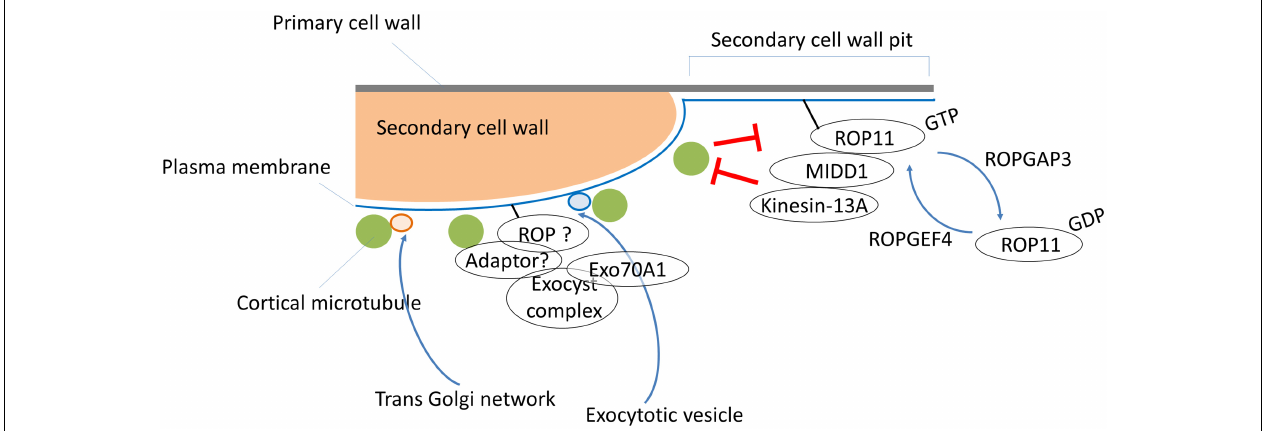
ROP pathway and/or an ROP-independent pathway that controls targeting of exocytotic vesicles through EXO70A1. An adaptor protein such as RIP1/ICR1 might mediate interactions between the putative ROP, exocysts, and cortical microtubules. Vesicles from the trans -Golgi network are directly targeted to cortical microtubules, and subsequently supply cellulose synthase complexes to the cellular sites where microtubules are